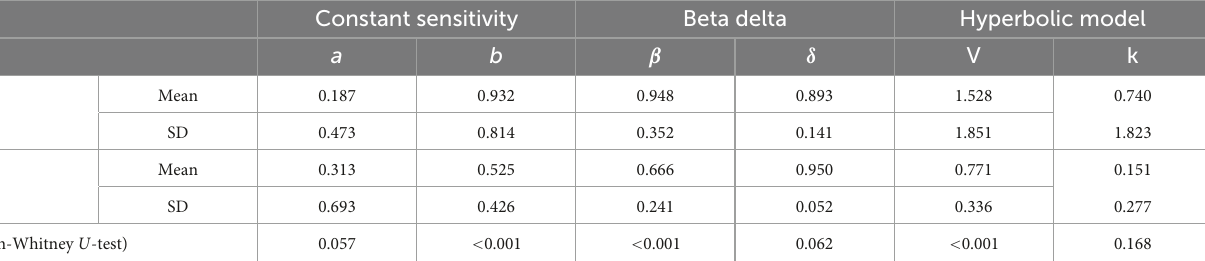
TABLE 5 Comparison of the parameters for each social discounting model.